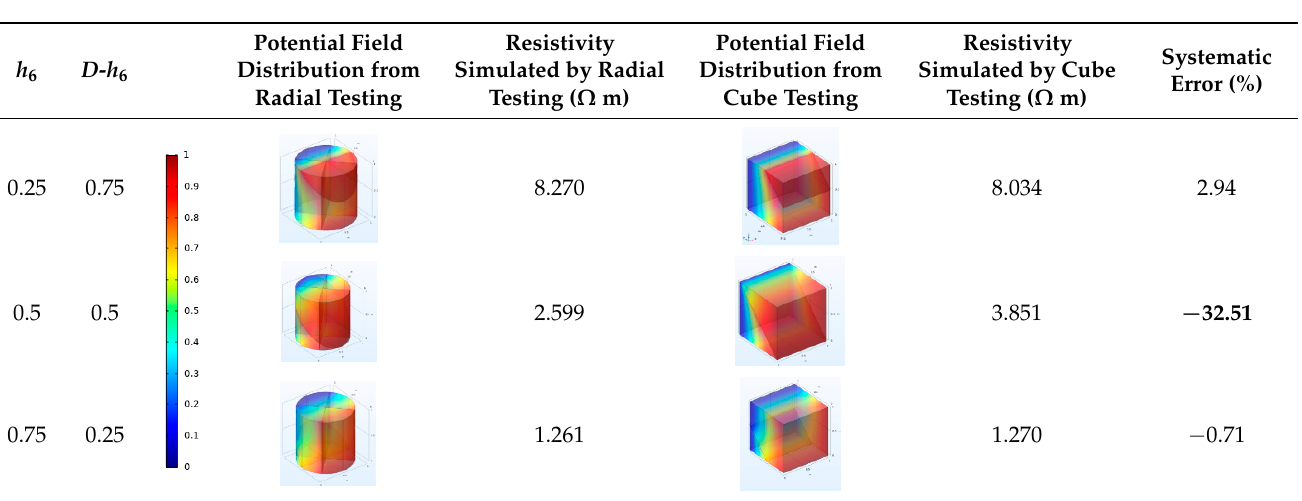
Table 5. Transitional Case 2 (another subtransition from Extreme 1 to Extreme 3): numerical sim- ulation results of different material thicknesses.